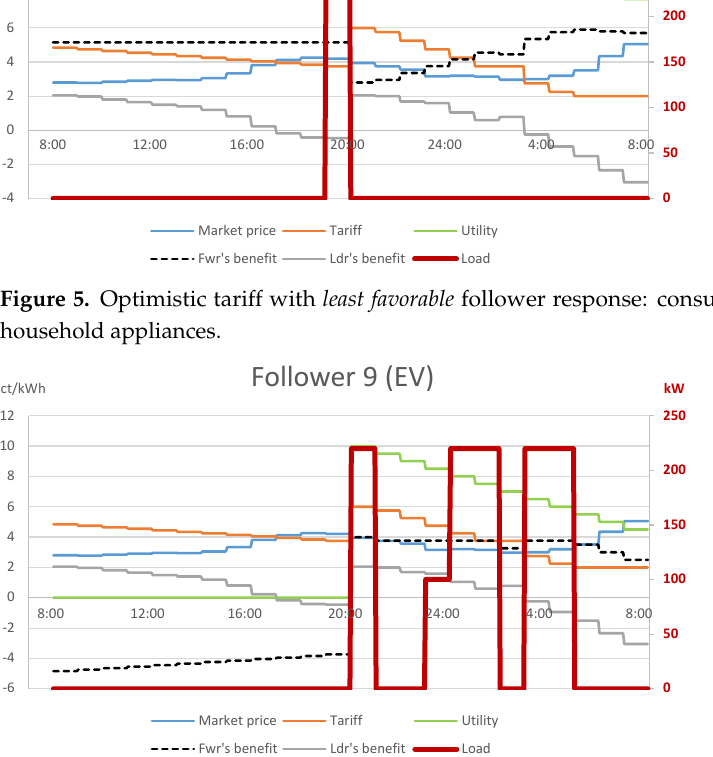
Figure 6. Optimistic tariff with the least favorable follower response: consumption of follower 9 with EV